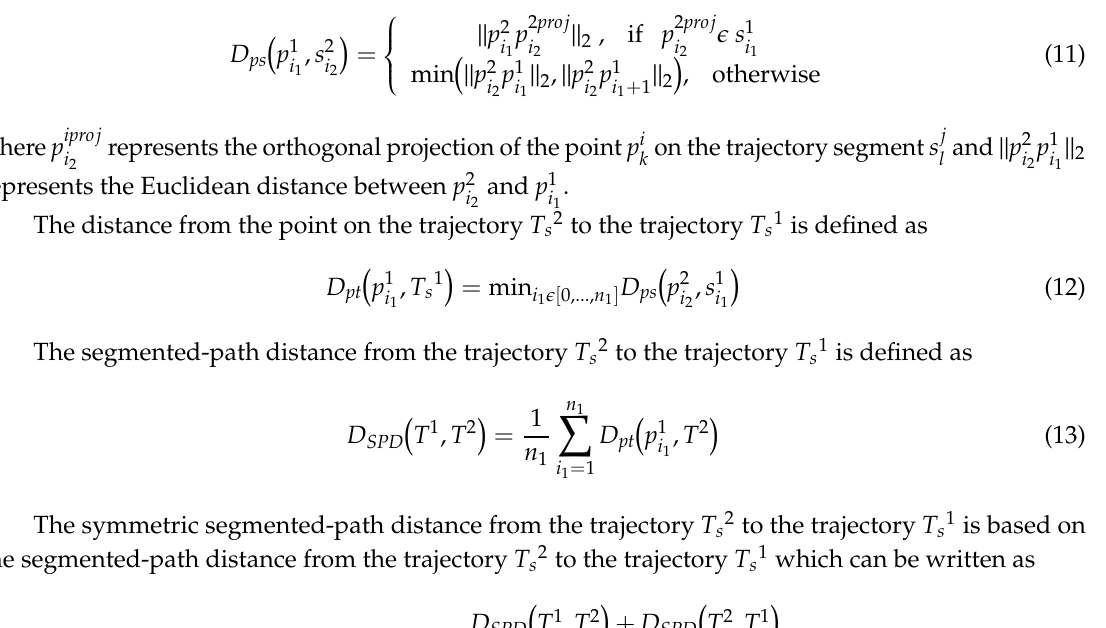
Figure 11. SPD distance from the trajectory 𝑇 (cid:2869) to the trajectory 𝑇 (cid:2870) .